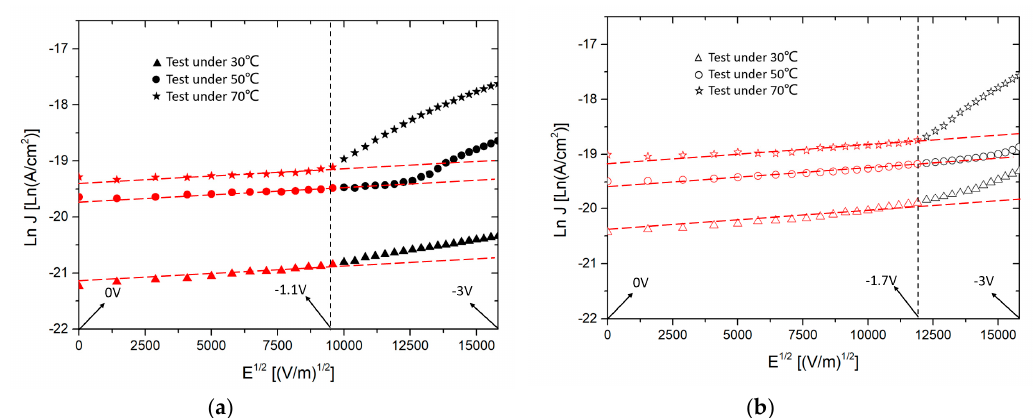
Figure 3. Schottky emission plots for MOS-capacitors at different temperatures. ( a ) Sample #1 with HfO 2 (4 nm)/Al 2 O 3 (8 nm) laminated dielectrics, ( b ) Sample #2 with HfO 2 (8 nm)/Al 2 O 3 (4 nm) laminated dielectrics. Table 2. Extracted barrier height ϕ B,n from the Schottky emission leakage mechanism at different temperatures.